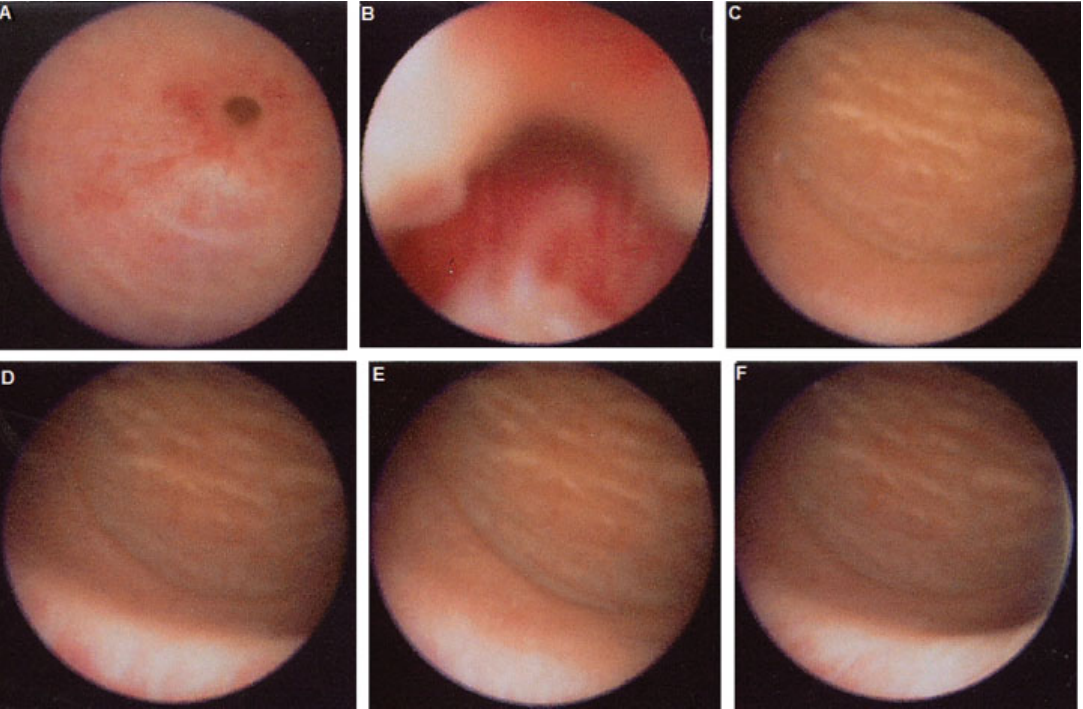
Fig. 1 Cystourethroscopic picture showing severe in fl ammation in and around verumontanum. ( A ) bulbous urethra, ( B ) posterior urethra, ( C ) bladder neck, ( D ) trigone, ( E ) ureteric ori fi ces, ( F )